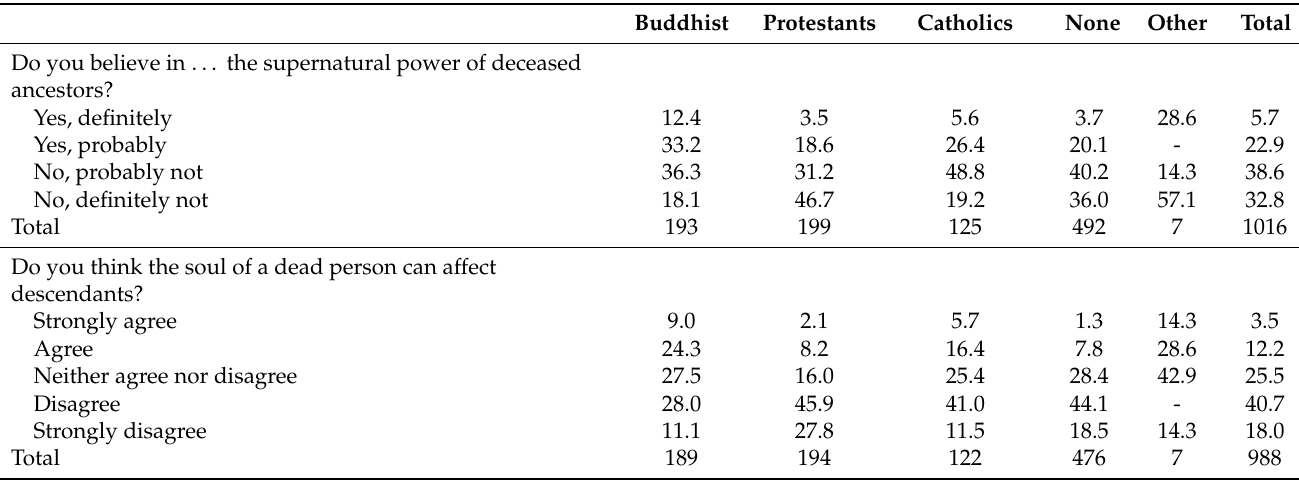
Table 4. Beliefs about ancestors (%), 2018 KGSS.